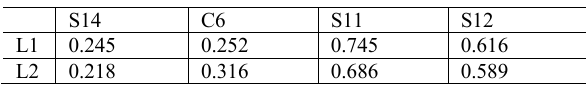
Table 3: Correlations: knowledge leadership, vision, strategy, culture and structure